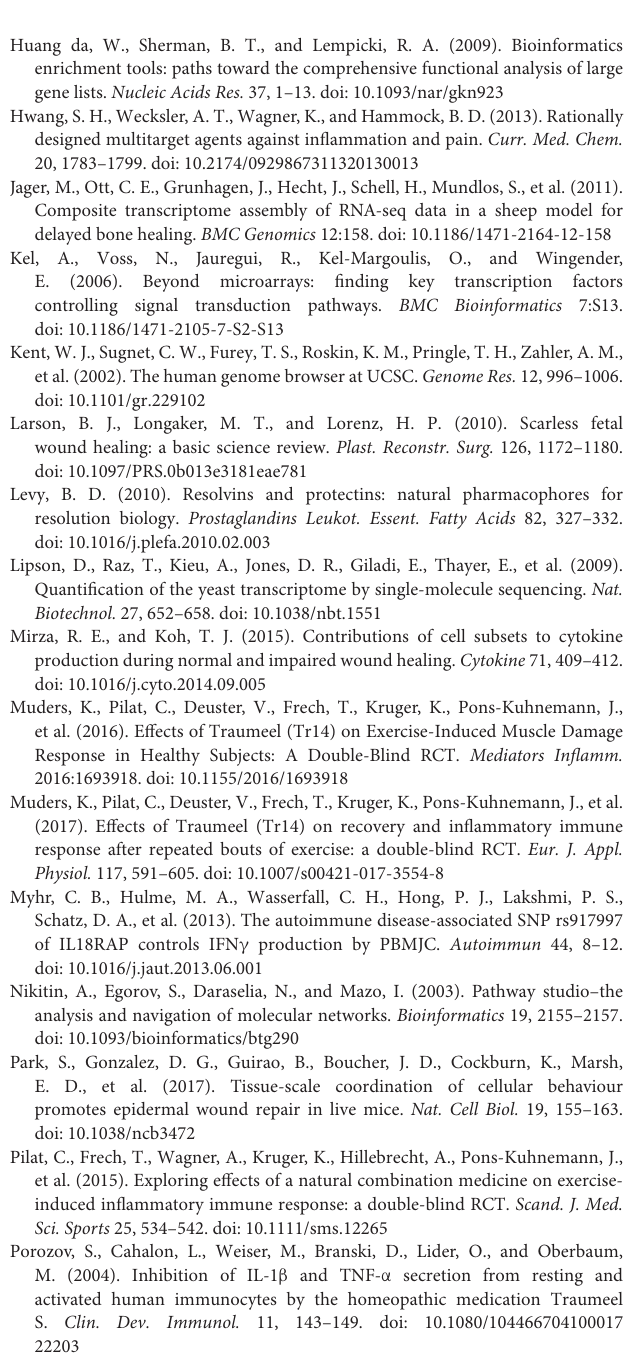
Supplementary Table 5 | Raw data for RNA sequencing analysis of mouse wound repair. The raw RPKM data for gene expression for all groups, animals, and time points is reported in the following tables. (A) Reports the (U) group of placebo treated animals, (B) reports the (S) saline injected control group, (C) reports the (I) Traumeel injection group, and (D) reports the (IO) Traumeel injection plus the Traumeel ointment group. (E) Reports a summary of the sequencing data with respect to total raw reads, filtered reads, Informative Reads and the number of expressed transcripts for each sample in the study, by